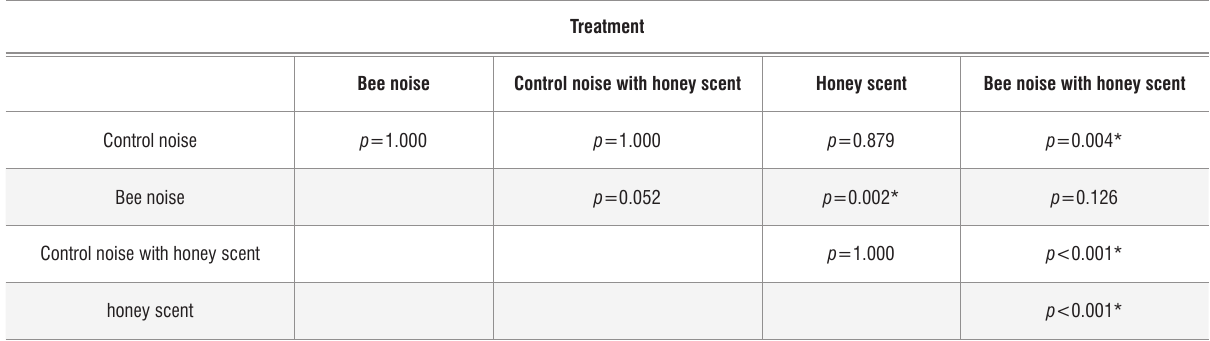
Control noise with honey scent honey